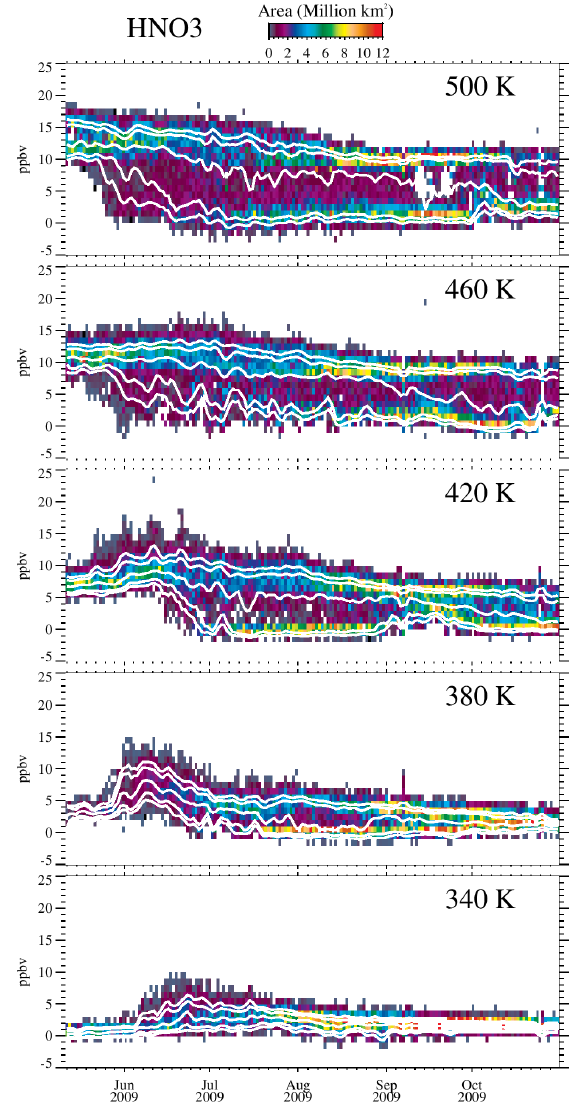
Figure 10. Time series of the distribution of MLS HNO 3 in the Antarctic from May to October 2009, for equivalent latitudes less than 60 ◦ S, and for isentropic levels from 340 to 500K. Major tick marks indicate the beginning of the month. The color scale indicates the areal coverage. White solid lines indicate the 10th, 20th, 50th (i.e., median), 80th, and 90th percentiles of the HNO 3 probability density